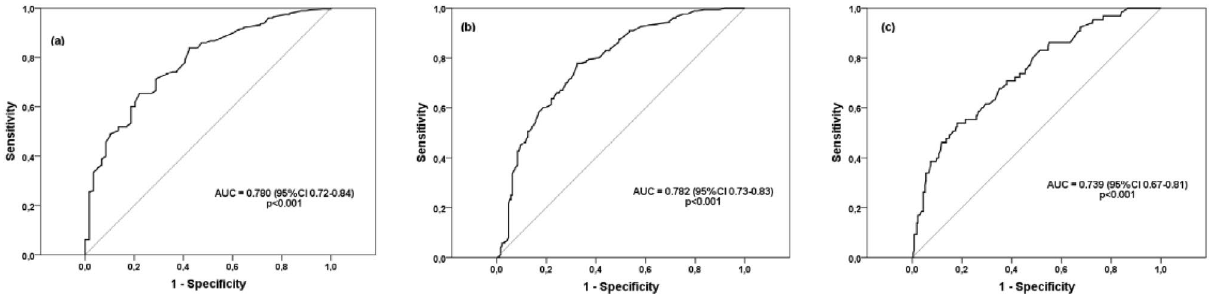
Figure 1. ( a ) ROC curve to show IL8 capacity to discriminate silicosis diagnosis from silica exposure. ( b ) ROC curve to show IL-8 capacity to discriminate complicated silicosis from the rest of silica exposed subjects. ( c ) ROC curve to show IL-8 capacity to discriminate